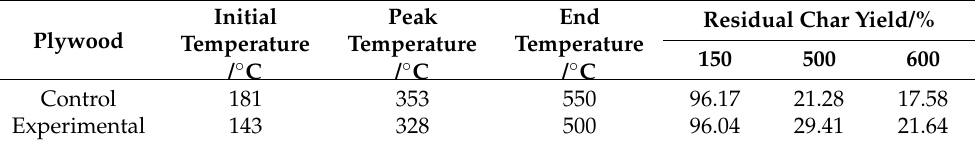
Figure 6. TG and DTG curves of plywood. Table 2. TG parameters of